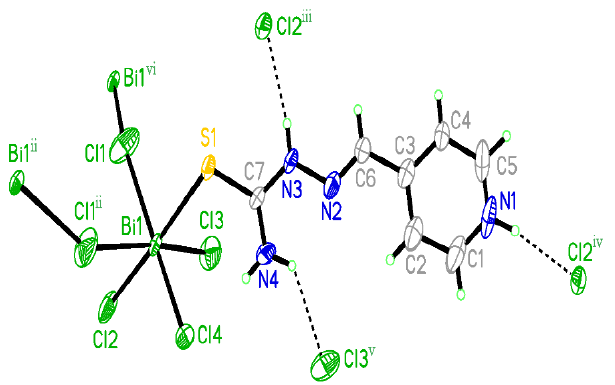
Figure 5. The crystal form of the coordination compound [Bi(HQ)(Cl) 4 ] n (Symmetry Code: #2 −x + 2, y + 1/2; #3 x, −y + 1/2, z + 1/2; #4 x − 1, −y + 1/2, z + 1/2; #5 −x + 1, y + 1/2, −z + 1/2; #6 −x + 2, y − 1/2, −z + 0.5).